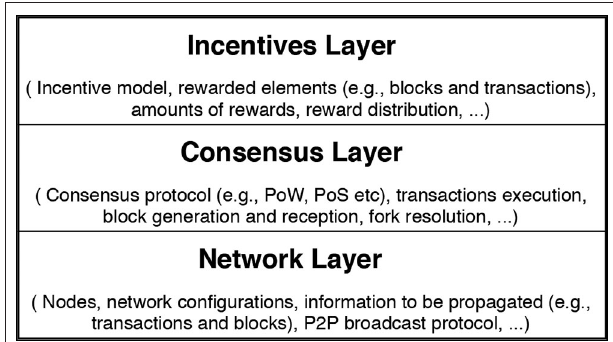
FIGURE 1 | Blockchain system